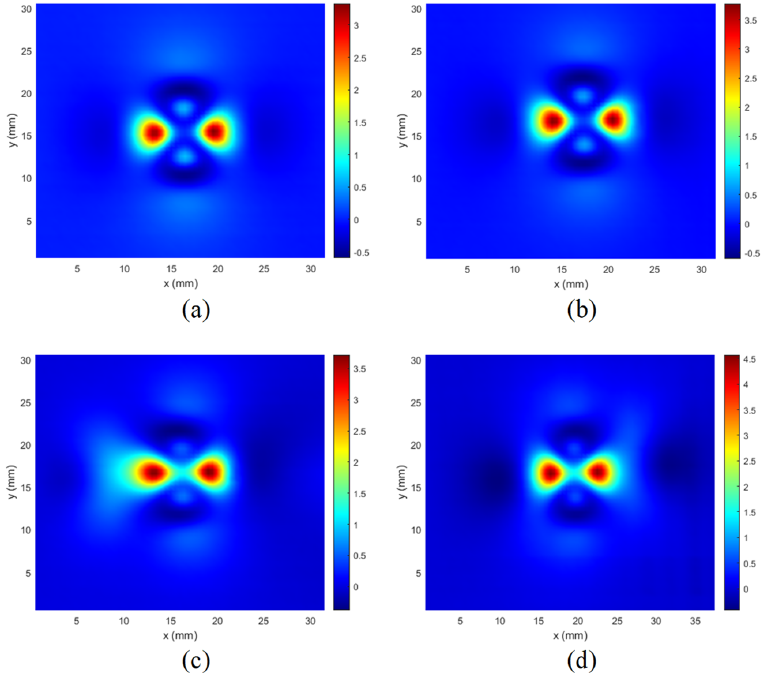
Figure 15. Comparison of C-scans: ( a ) achieved in case of the specimen without defect; ( b ) the specimens with the crack in the 1st layer, along the x -axis, and with a length of 2 mm; ( c ) length 5 mm; ( d ) combined two cracks with a length of 2 mm and 5 mm.